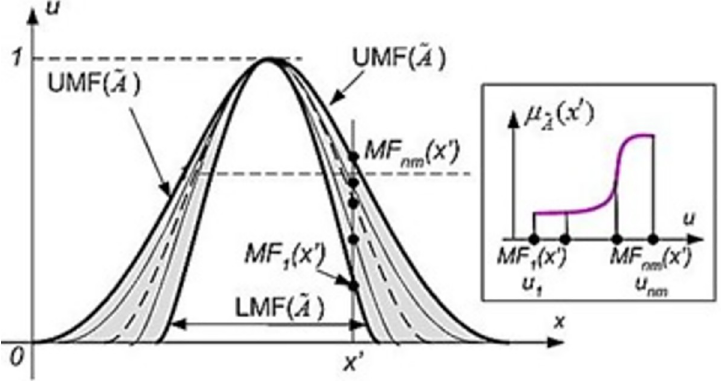
Fig 2. Type-2 membership function.